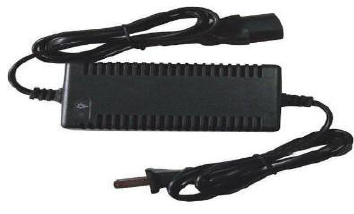
Fig 7. 12 V-1.7A Adapter